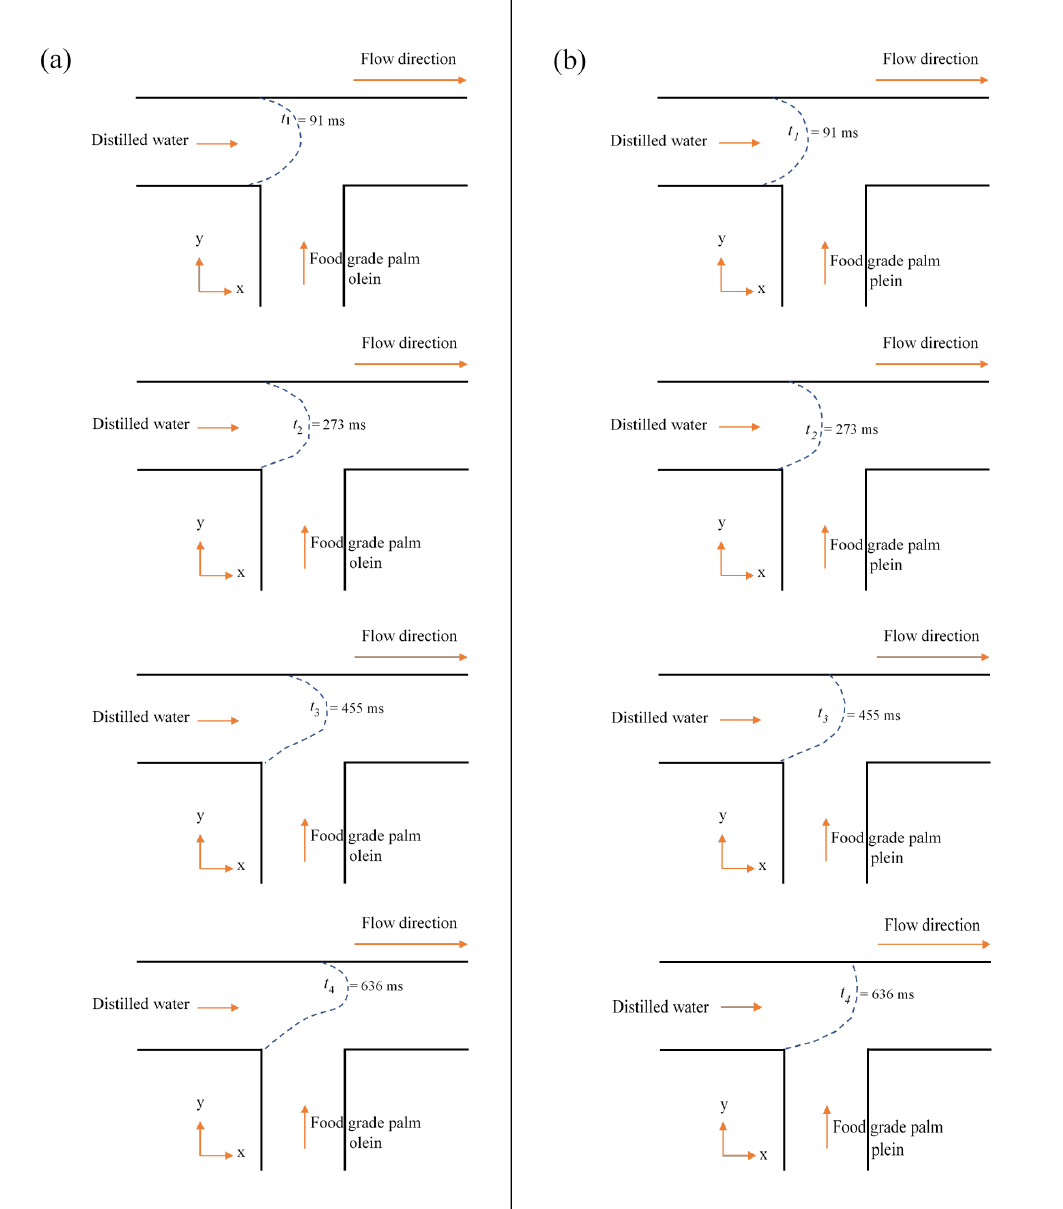
Figure 3. The evolution of water droplets for offset T-junction microchannels with radiuses of ( a ) 400 µm, and ( b ) 750 µm at t 1 = 91 ms until t 4 = 636 ms.